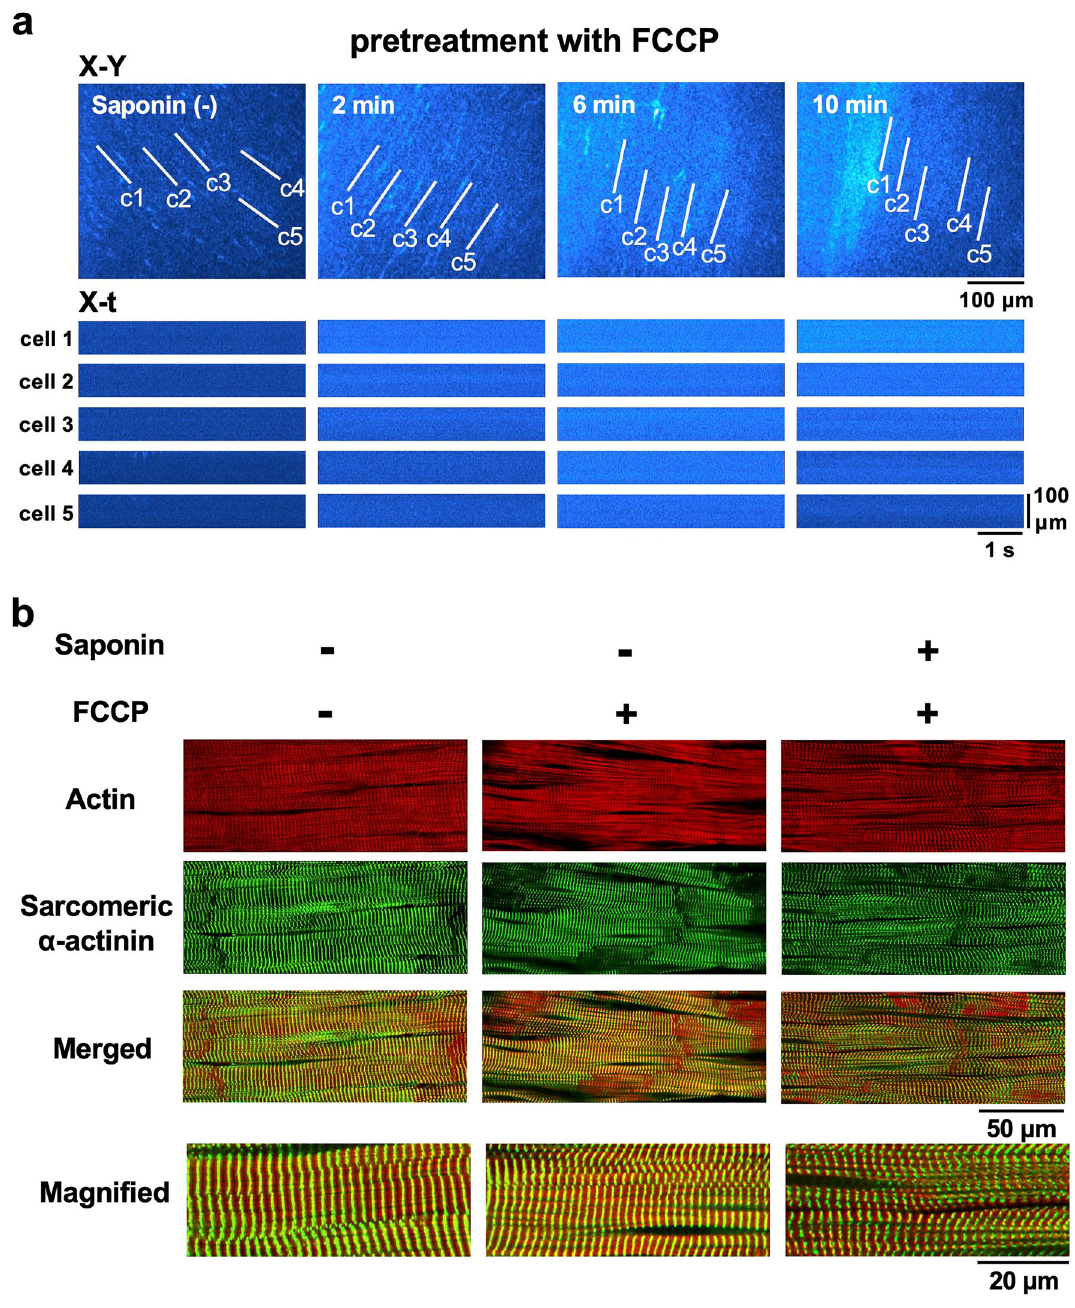
Figure 7. Saponin attenuates contraction-band formation in the myocardium treated with the mitochondrial uncoupling agent FCCP. ( a ) Fluo4-fluorescence images of the myocytes (cell 1–cell 5) before and 2-, 6-, and 10-min after the addition of saponin in the presence of FCCP at 10 μM. ( b ) Confocal fluorescence images of both actin filaments and α-actinin in the subepicardial myocardium of the control ( left ), in the presence of 10 μM FCCP ( middle ), and saponin treatment in the presence of FCCP ( right